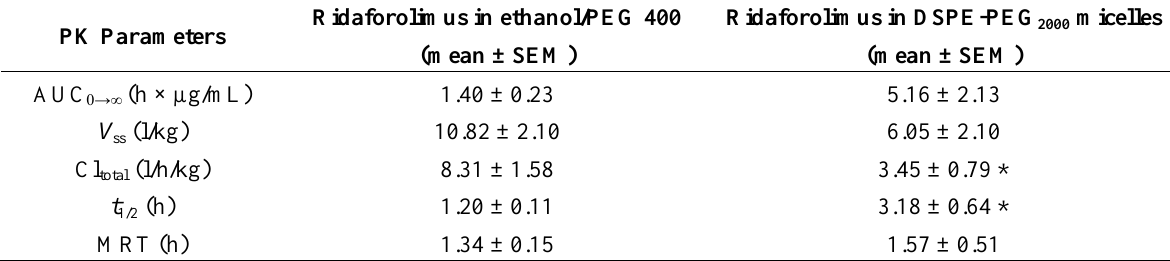
Table 1. Pharmacokinetics of ridaforolimus after IV administration of control ridaforolimus in ethanol/PEG 400 and ridaforolimus in DSPE-PEG intravenous dose for all the formulations was 10 mg/kg to rats (mean ± SEM, n = 7 per group). * Significantly different from formulation in ethanol/PEG 400 ( p <